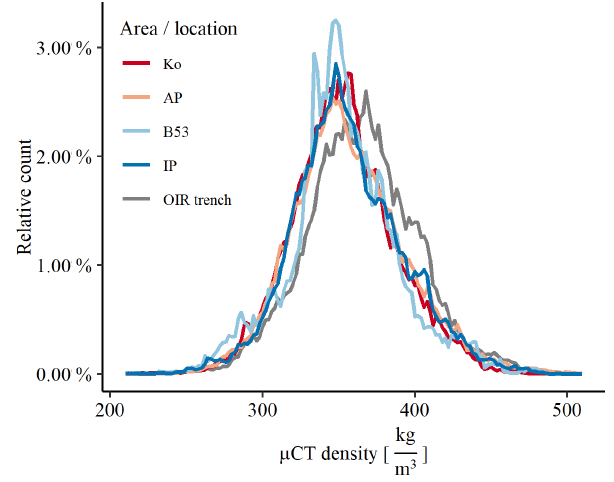
Figure 9. Density distribution from surface to 1m depth of the µ CT density. It is based on all available liners – 114 liners from the tra- verse (according to their subregion), 30 liners for the OIR trench (grey) and 16 liners from Kohnen Station (not this study) with a bin width of 2kgm − 3 . We used the same color code for the subregions (Sect. 2.5) as in Fig. 1. Table 3. Confidence intervals of 95% for each pooled area. Lower Upper boundary